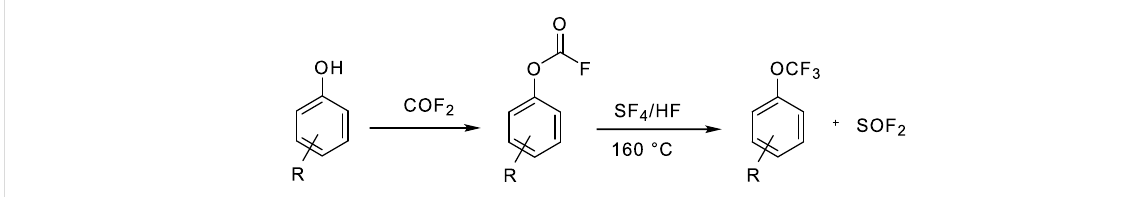
Scheme 4: Preparation of trifluoromethyl ethers via fluoroformates.